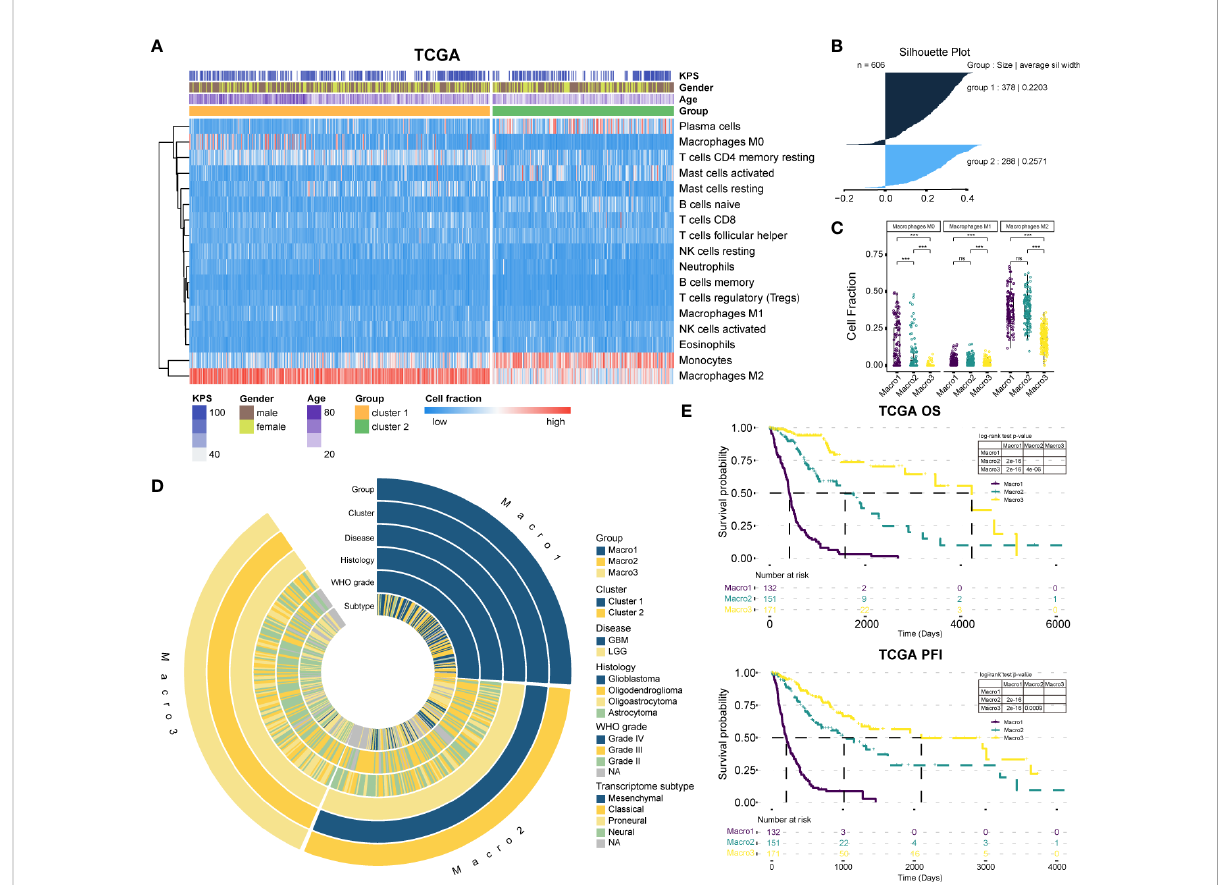
FIGURE 1 The classi fi cation of gliomas. (A) The abundance of estimated immune in fi ltration of glioma clusters. Five types of cells including dendritic cells activated, dendritic cells resting, T cells CD4 memory activated, T cells CD4 naïve, and T cells gamma delta were excluded for low content. (B) The silhouette width for the selection of core samples of each cluster. (C) Comparison of the fraction of macrophages between glioma groups. (D) Association of the glioma groups with prevalent clinicopathological biomarkers. (E) The survival differences between glioma groups. ***p < 0.001. ns, non signi fi